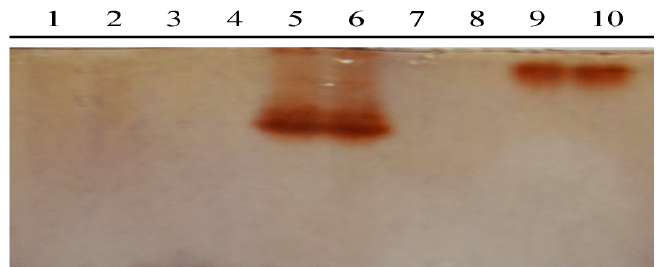
Figure 4. SDS-PAGE results of detecting polyphenol oxidase from protein extracts of poplar buds, poplar extracts, propolis, bee heads and bee